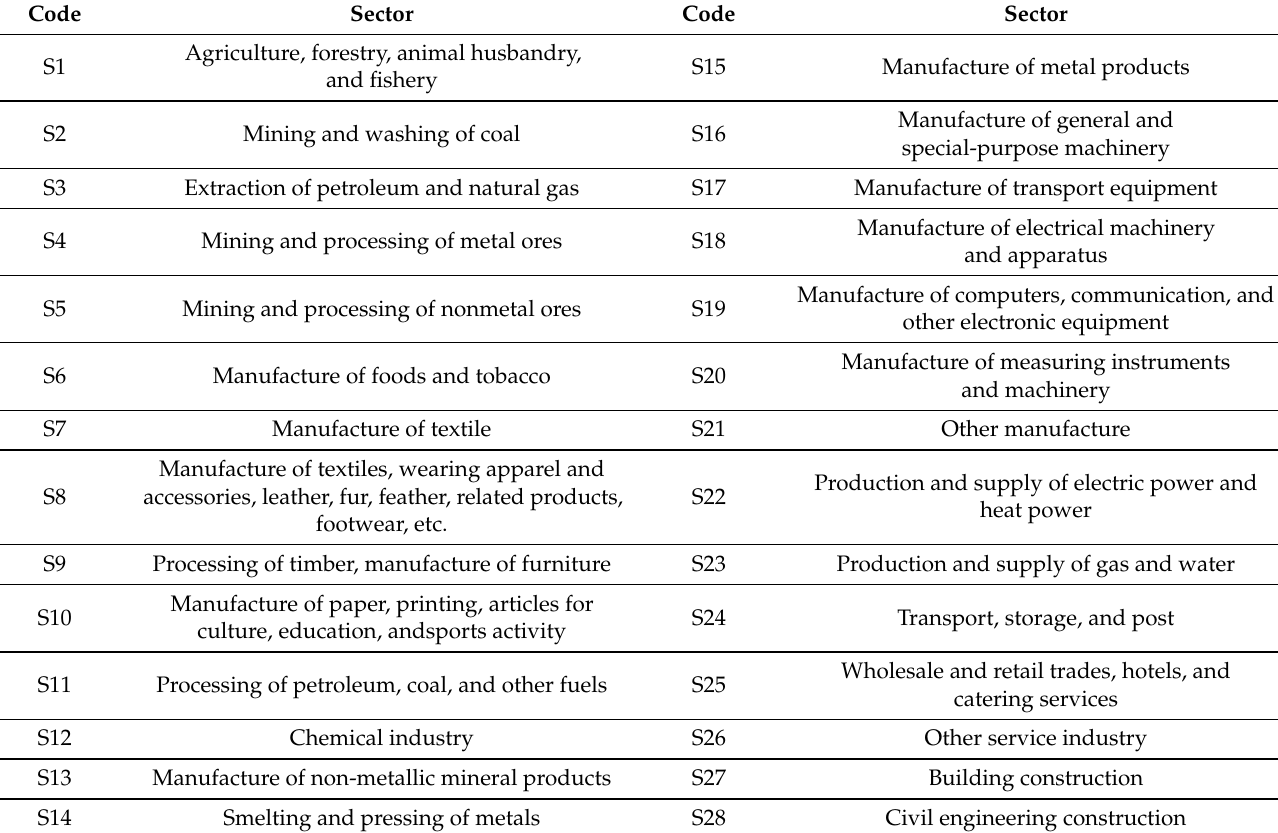
Table A1. Sectoral